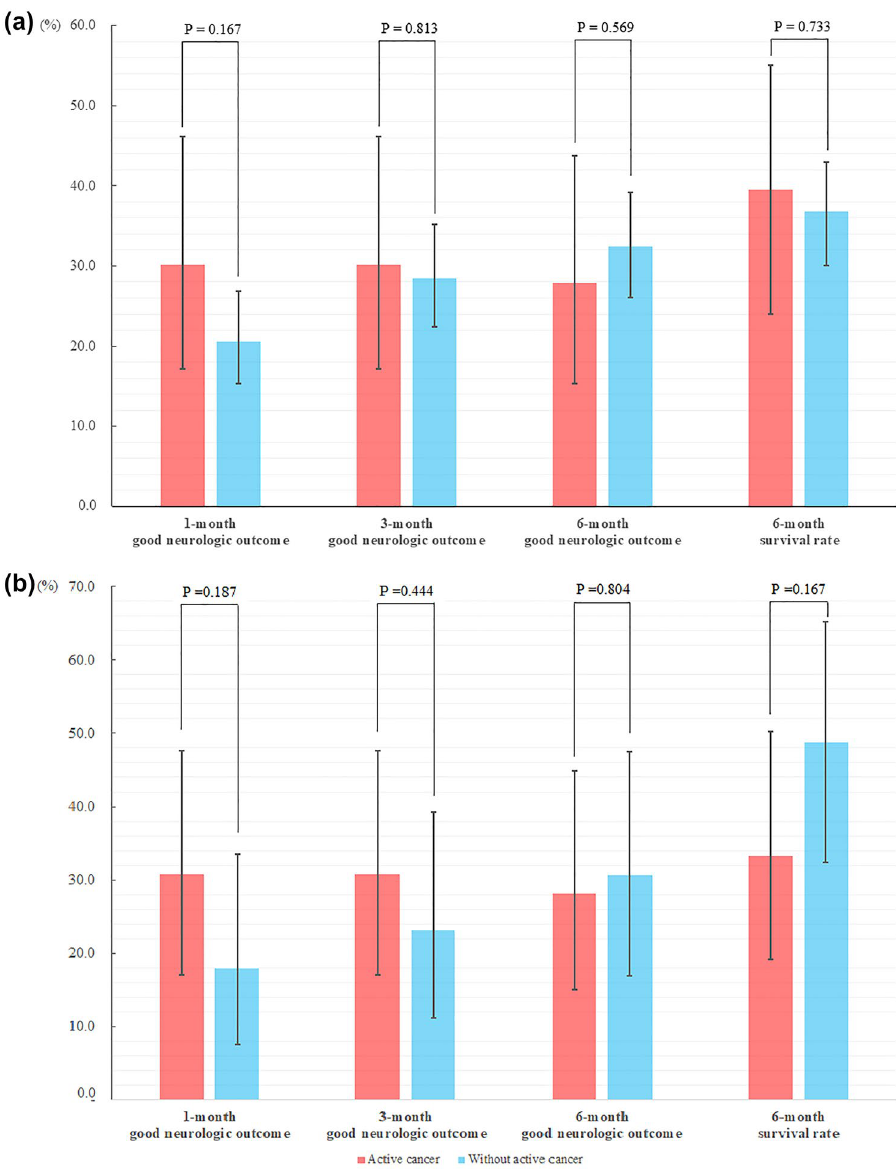
Figure 2. ( a ) Rates of good neurologic outcome at 1-, 3-, and 6-months, and the 6-month survival rates in patients with and without active cancer, ( b ) Analysis following matching with age, sex, comorbidities, presumed cause of arrest, and total resuscitation